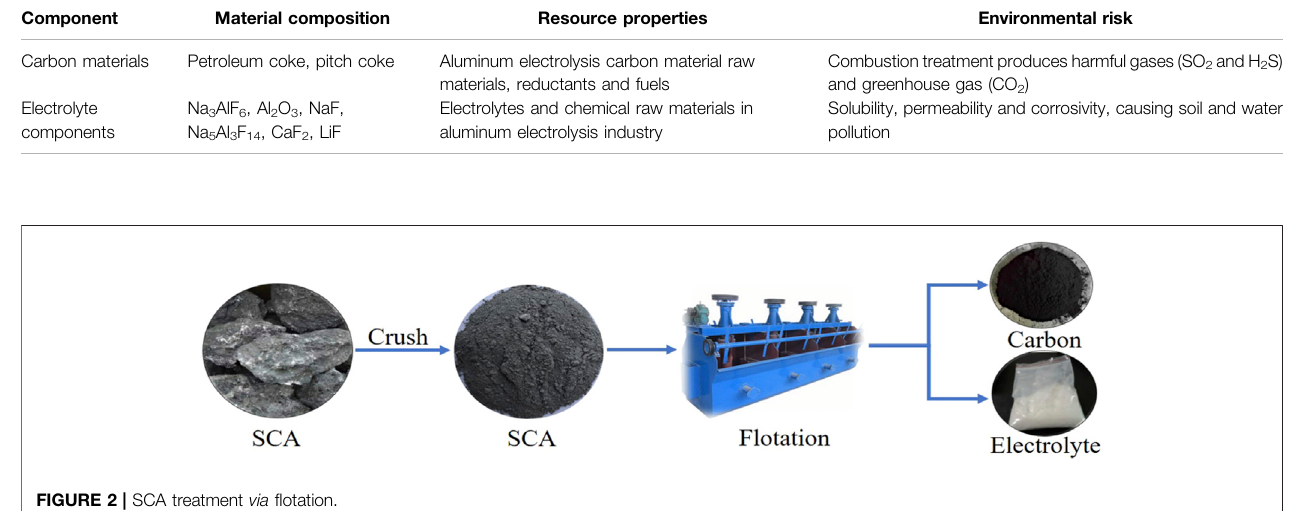
FIGURE 2 | SCA treatment via fl otation.